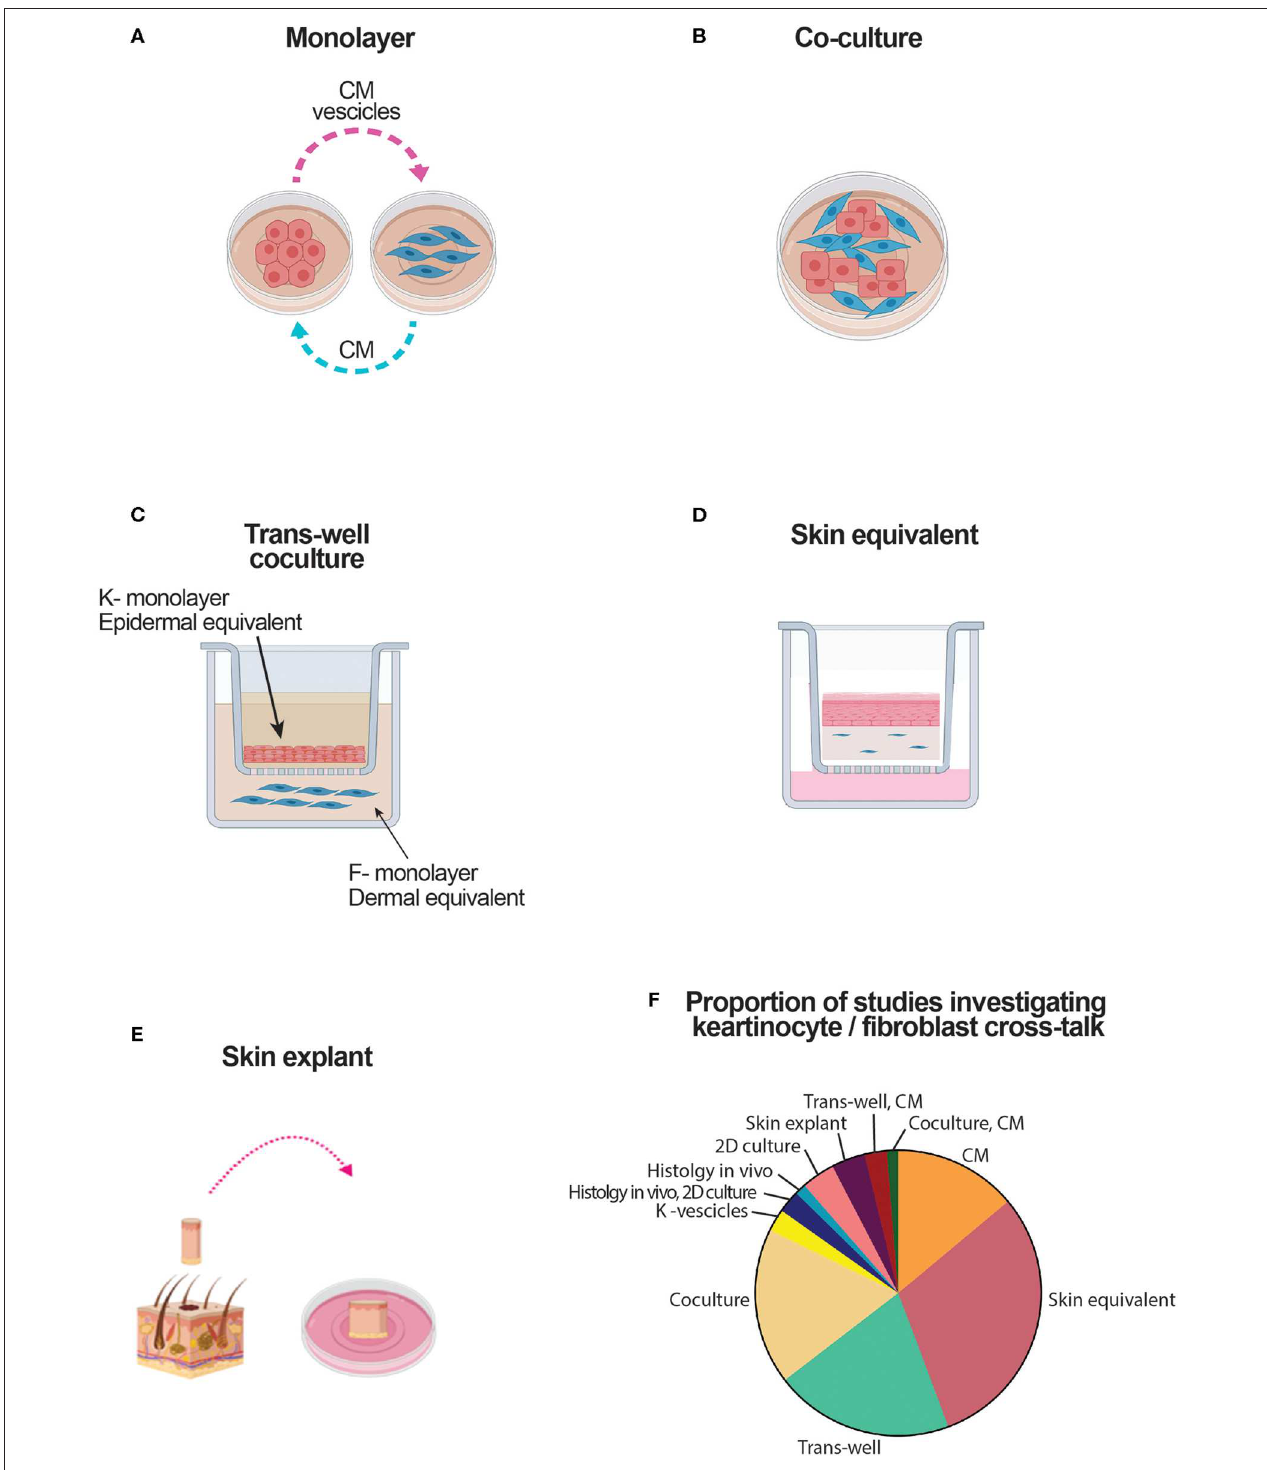
FIGURE 2 | Schematic representation of culture systems used to assess the crosstalk between keratinocytes and fibroblasts. CM, conditioned medium; DE, dermal equivalent; EE, epidermal equivalent; F, fibroblast; K, keratinocyte. (A) Culture based on the use of medium conditioned by one type of cell cultured in monolayer to modulate the response of the other cell type. (B) Culture based on a mix of keratinocytes and fibroblasts. (C) Culture based on the use of transwells. Keratinocytes either in monolayer, either in dermal equivalents are in the top well. Fibroblasts, either in monolayer either in dermal equivalent are in the bottom well. Soluble mediators cross the semipermeable transwell membrane. (D) Skin equivalent generated at the air liquid interphase. (E) Organotypic full skin culture obtained by skin biopsy. (F) Proportion of the studies addressing keratinocyte-fibroblast crosstalk which results are reviewed here.